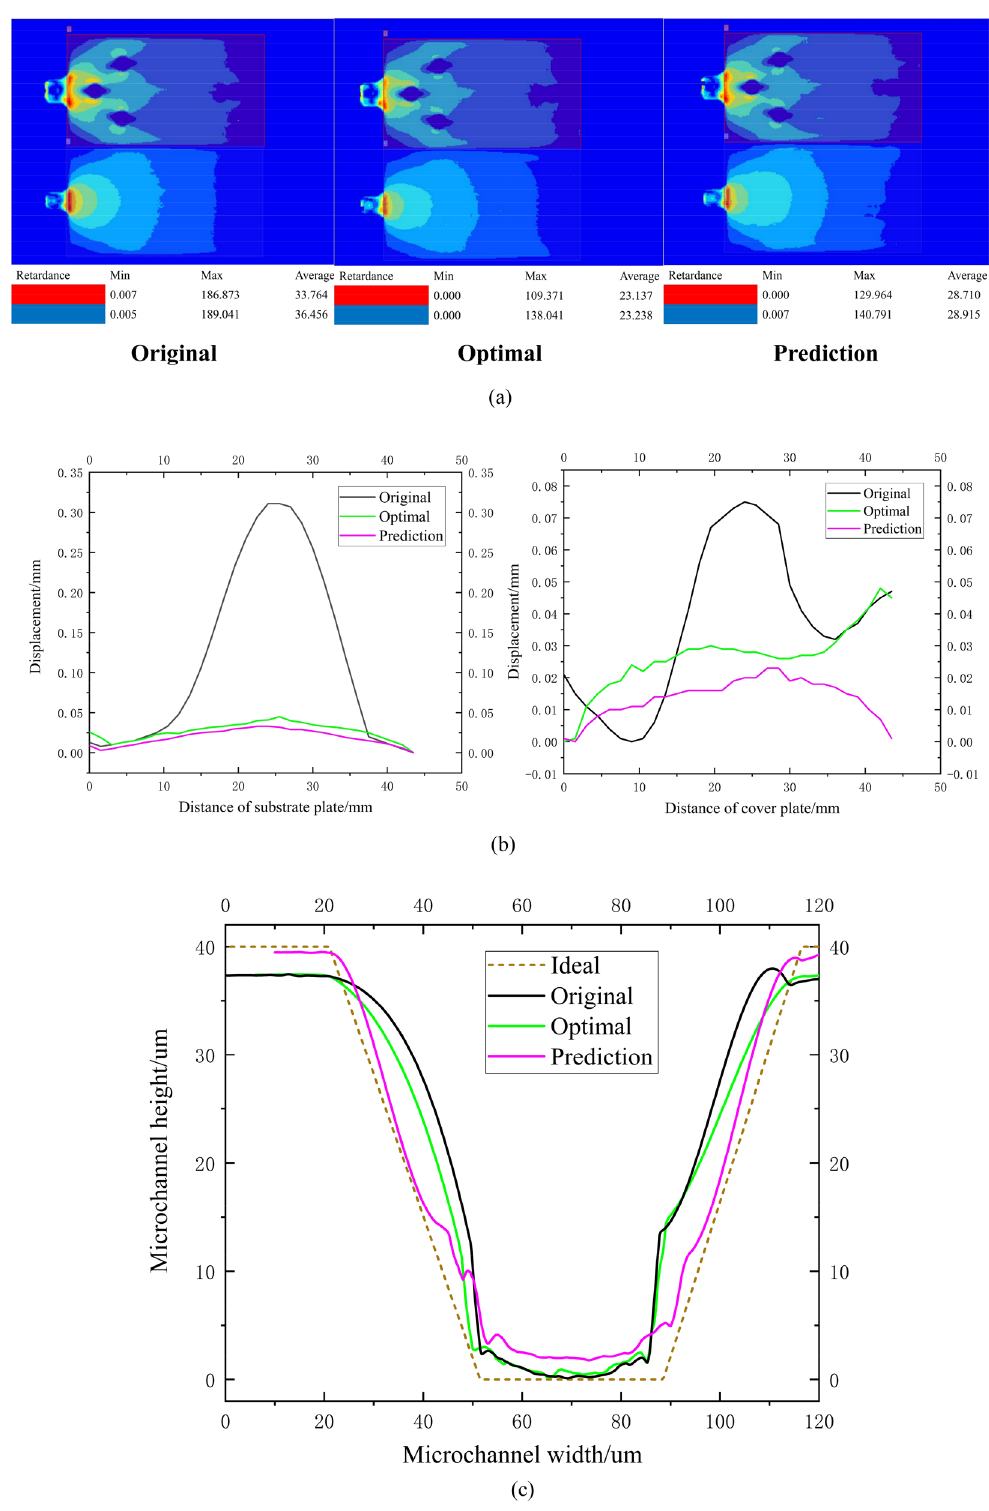
Figure 10. Comparison of the original scheme, the optimal scheme and the prediction scheme in an experiment. ( a ) The residual stress of substrate and cover plate. ( b ) The warpage of substrate and cover plate. ( c ) The replication fidelity of microchannel for substrate